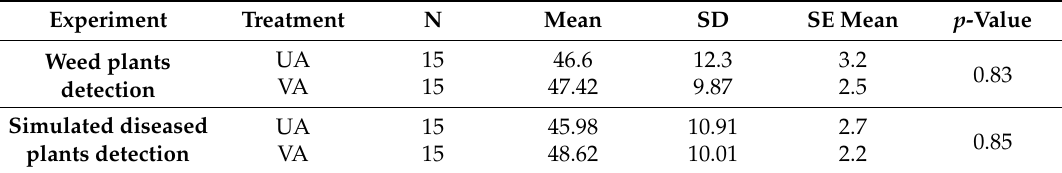
Figure 8. Processed images of water-sensitive papers for uniform application treatment showing the percent areas coverage of targets (purple) and non-target (yellow) missed during uniform application of the spraying liquid. The numbers below each image of the water-sensitive paper represent blue ratio; i.e., ratio (to be considered as percent area coverage of uniform application treatment) of image pixels turned into blue after receiving the spraying liquid (target detected) to the total image pixels. Table 7. Results of the t -test to compare the performance of the newly developed smart variable rate sprayer in comparison to uniform application.